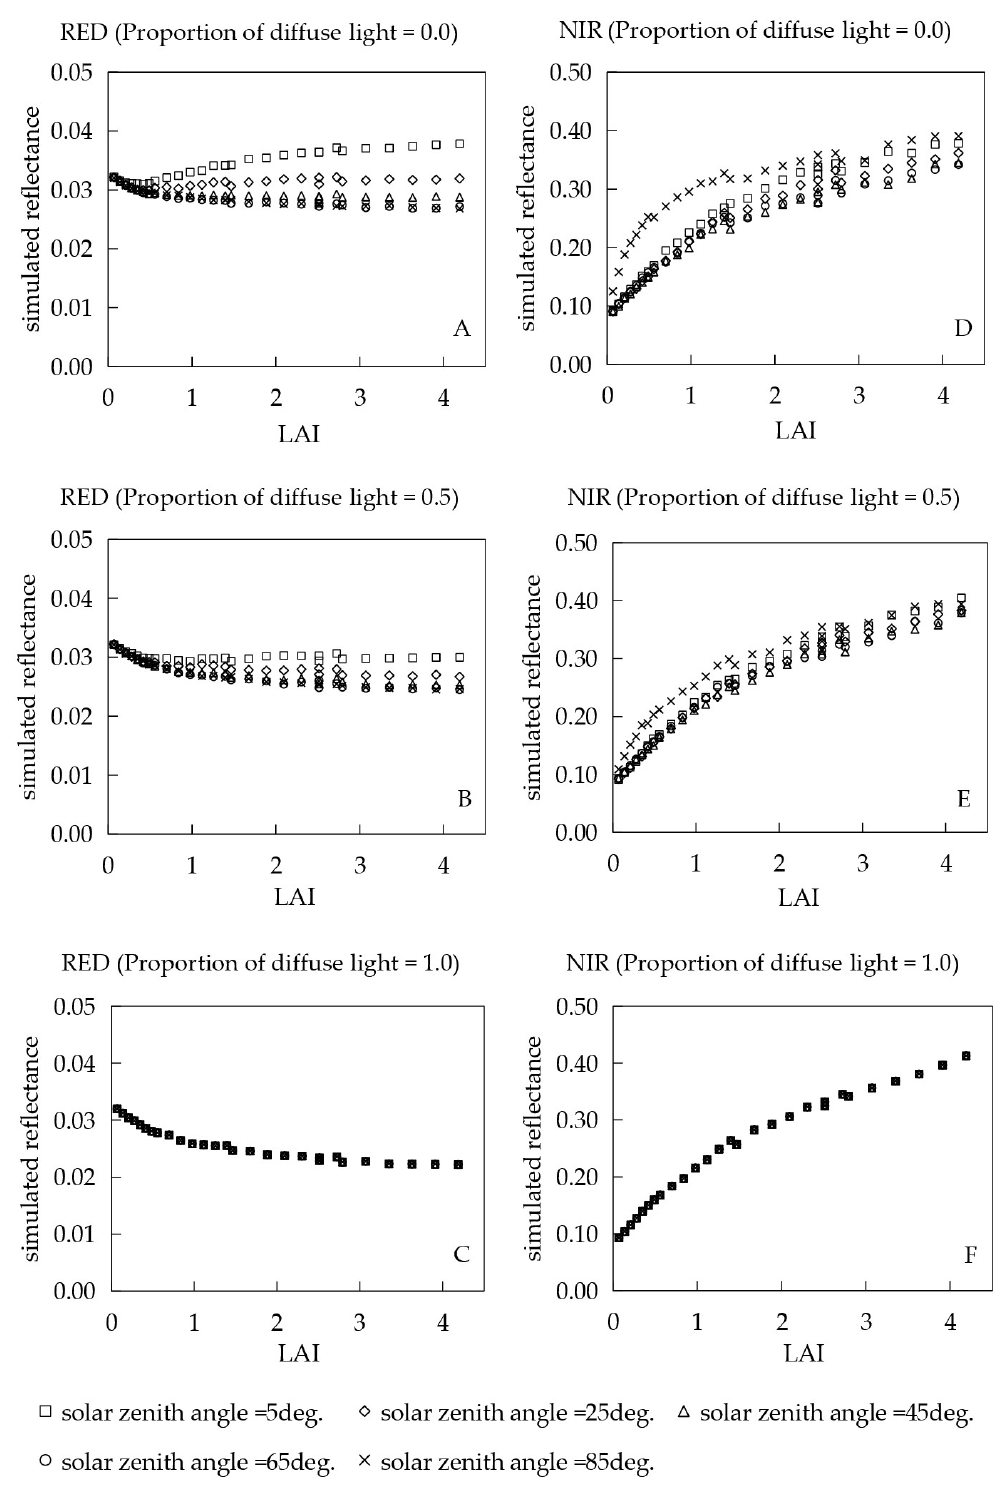
Figure 2. Results of simulating canopy reflectance of RED (A, B and C) and NIR (D, E and F) using the parameters shown in Table 1. The simulation was performed by changing the proportion of di ff use light at 0.0 (A and D), 0.5 (B and E), and 1.0 (C and F) and the solar zenith angle at 5, 25, 45, 65, and 85 degrees. The simulated reflectance of RED and NIR was plotted against leaf area index (LAI), which was calculated by multiplying the number of plants, the plant foliage volume and leaf area density (LAD) in the foliage. Symbols distinguish solar zenith angle at 5, 25, 45, 65 and 85